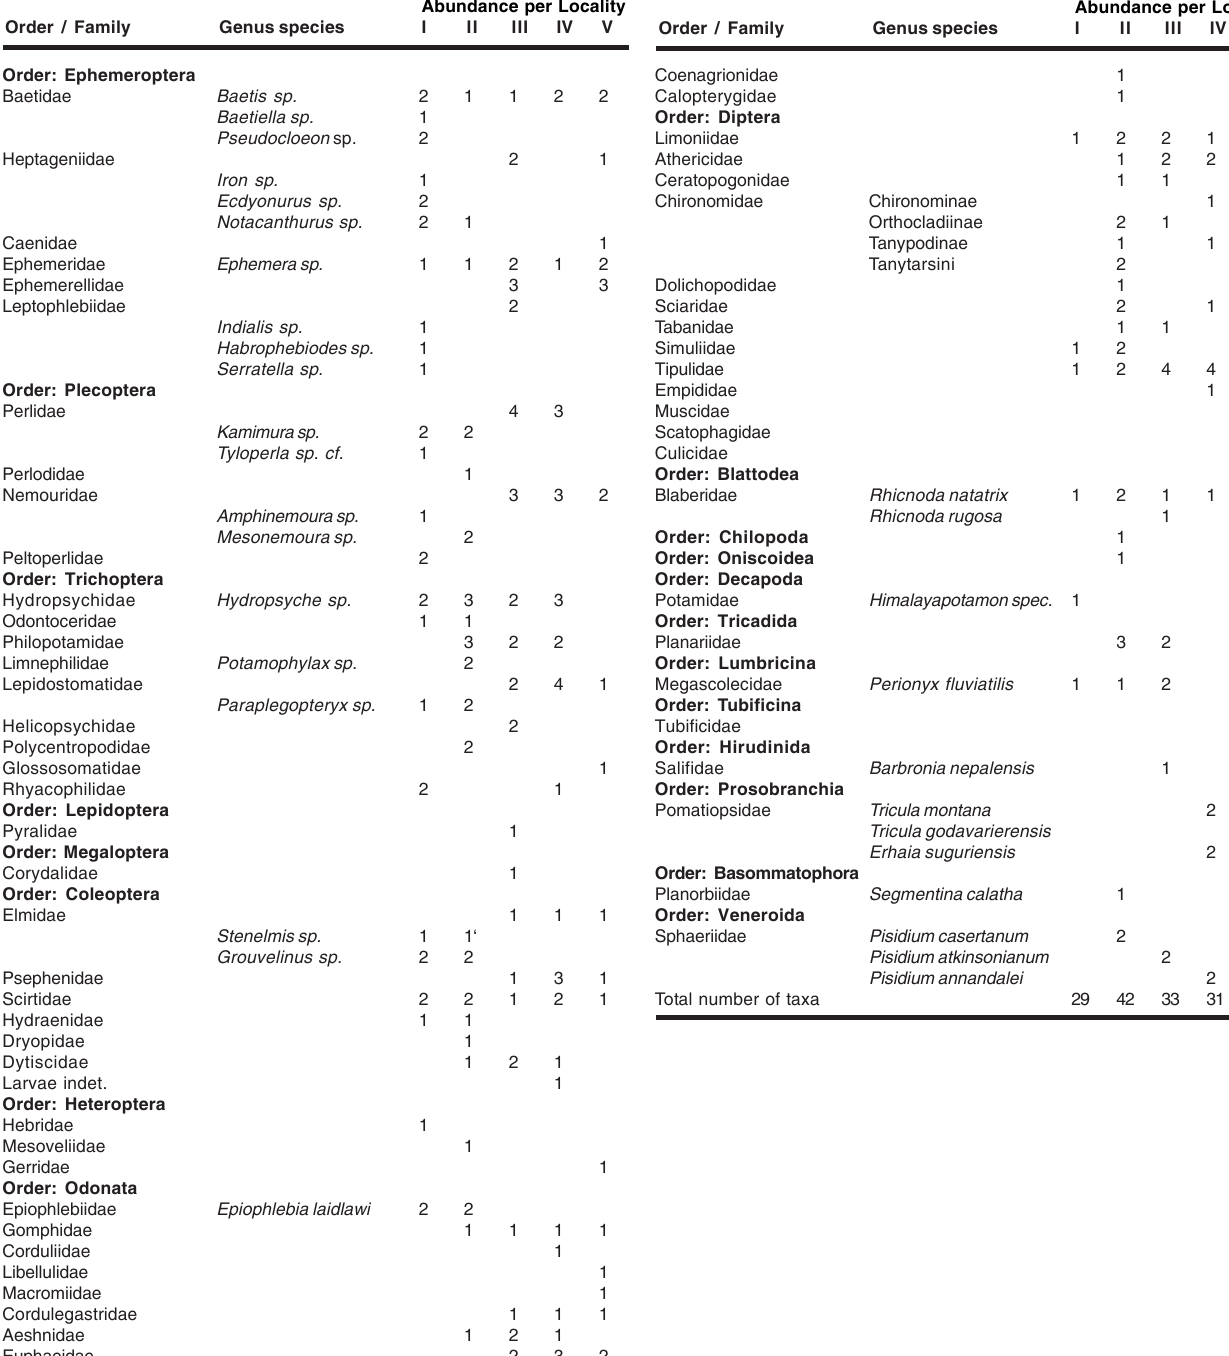
Abundance per Locality